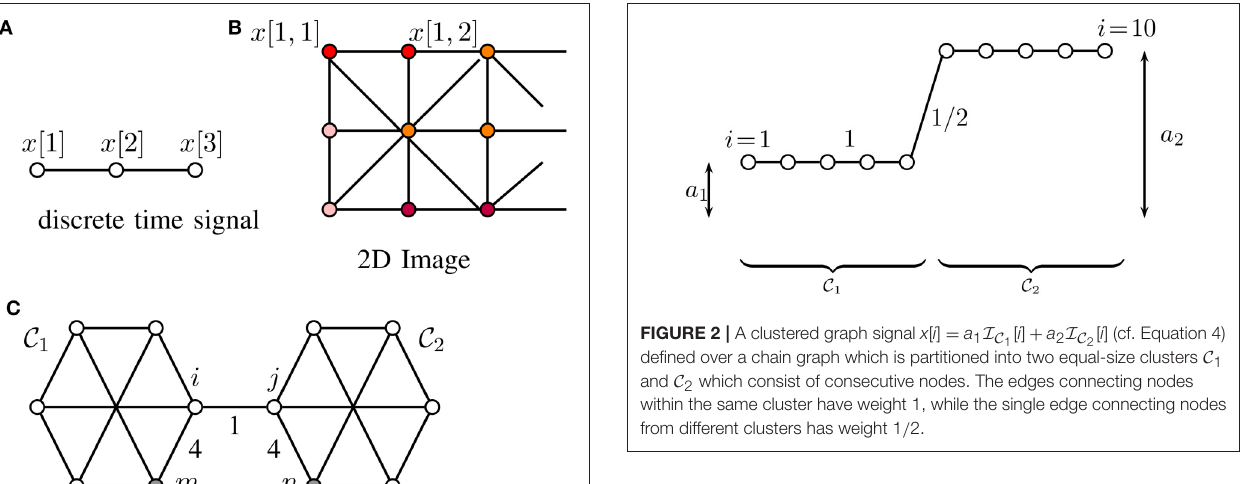
FIGURE 2 | A clustered graph signal x [ i ] = a 1 I C defined over a chain graph which is partitioned into two equal-size clusters C 1 and C 2 which consist of consecutive nodes. The edges connecting nodes within the same cluster have weight 1, while the single edge connecting nodes from different clusters has weight 1 /